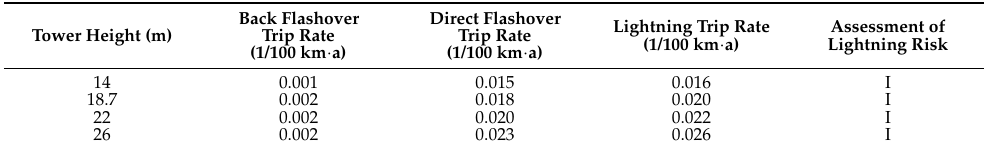
Table 2. Lightning trip rate of the line under the tower height